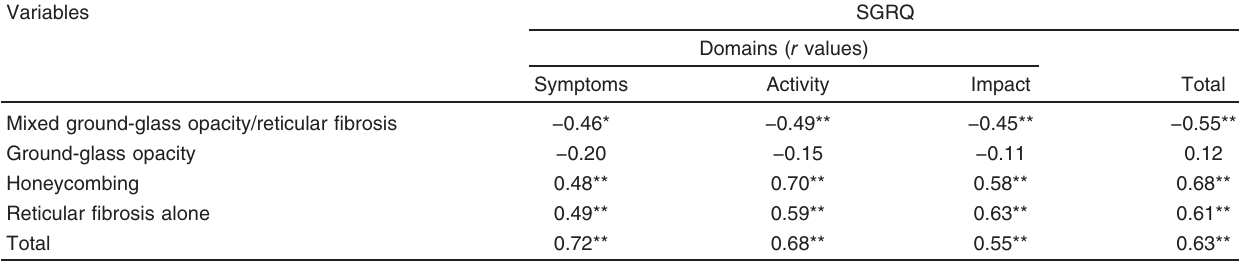
Table 5 Correlation between high-resolution computed tomography and Saint George Respiratory Questionnaire